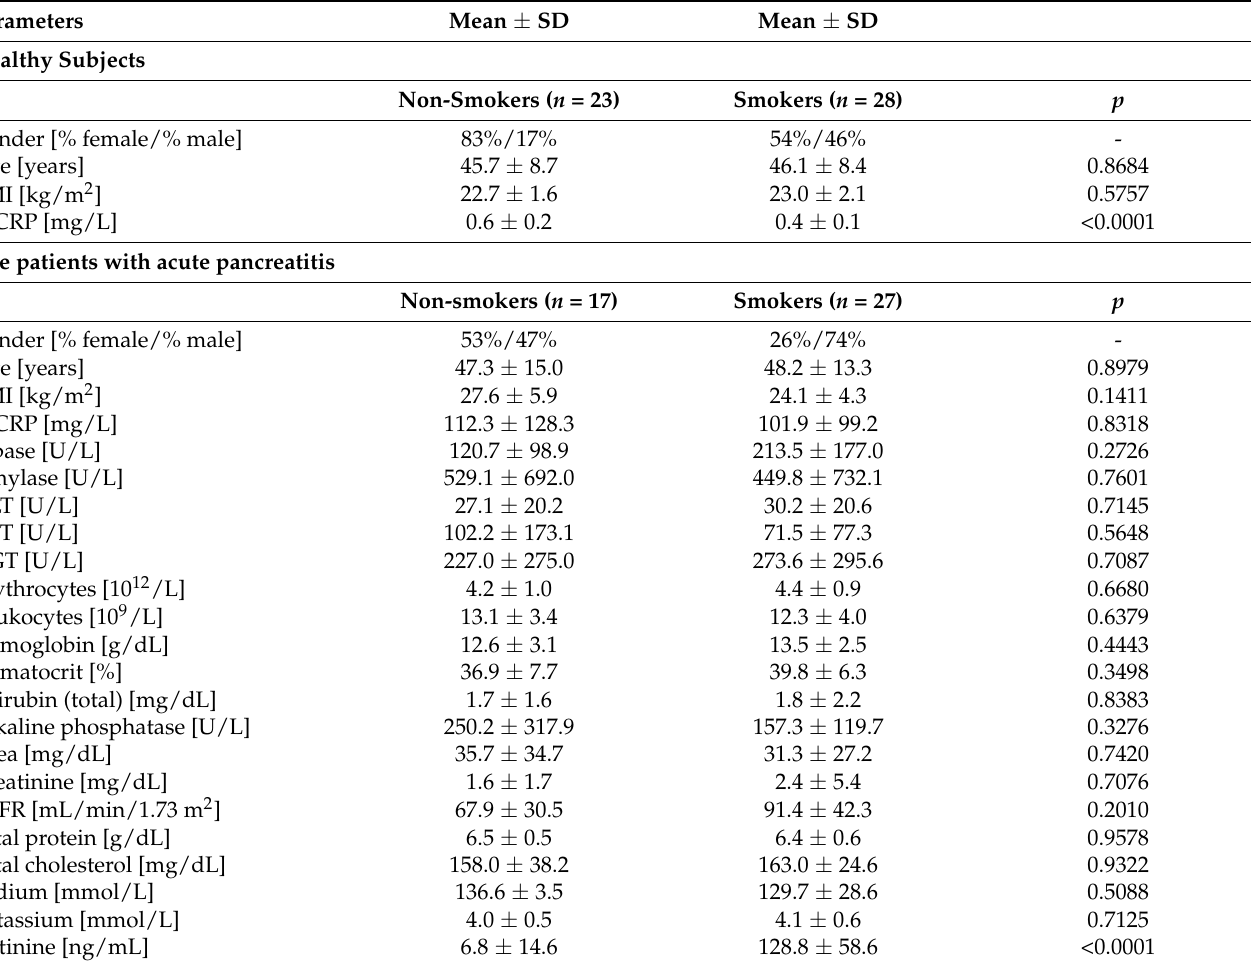
Table 1. Clinical characteristics of the healthy subjects and patients with acute pancreatitis on the first day of